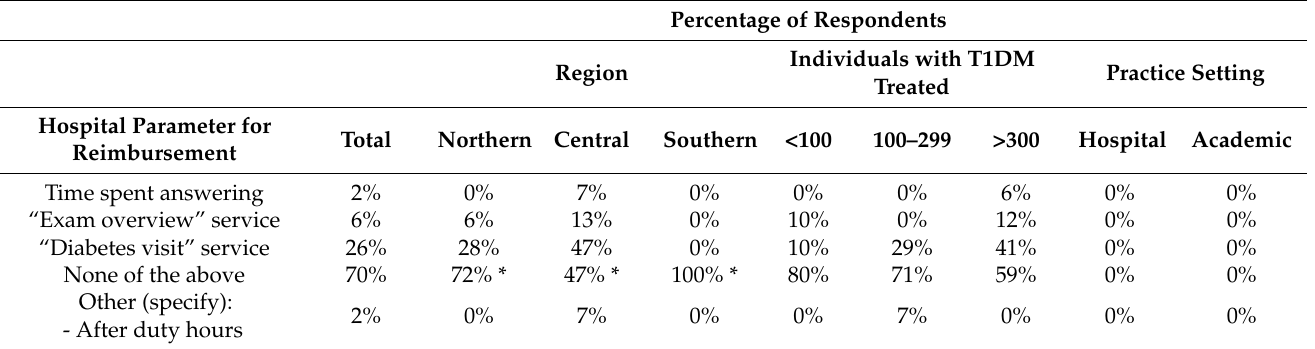
Table 4. Reimbursement of telemedicine